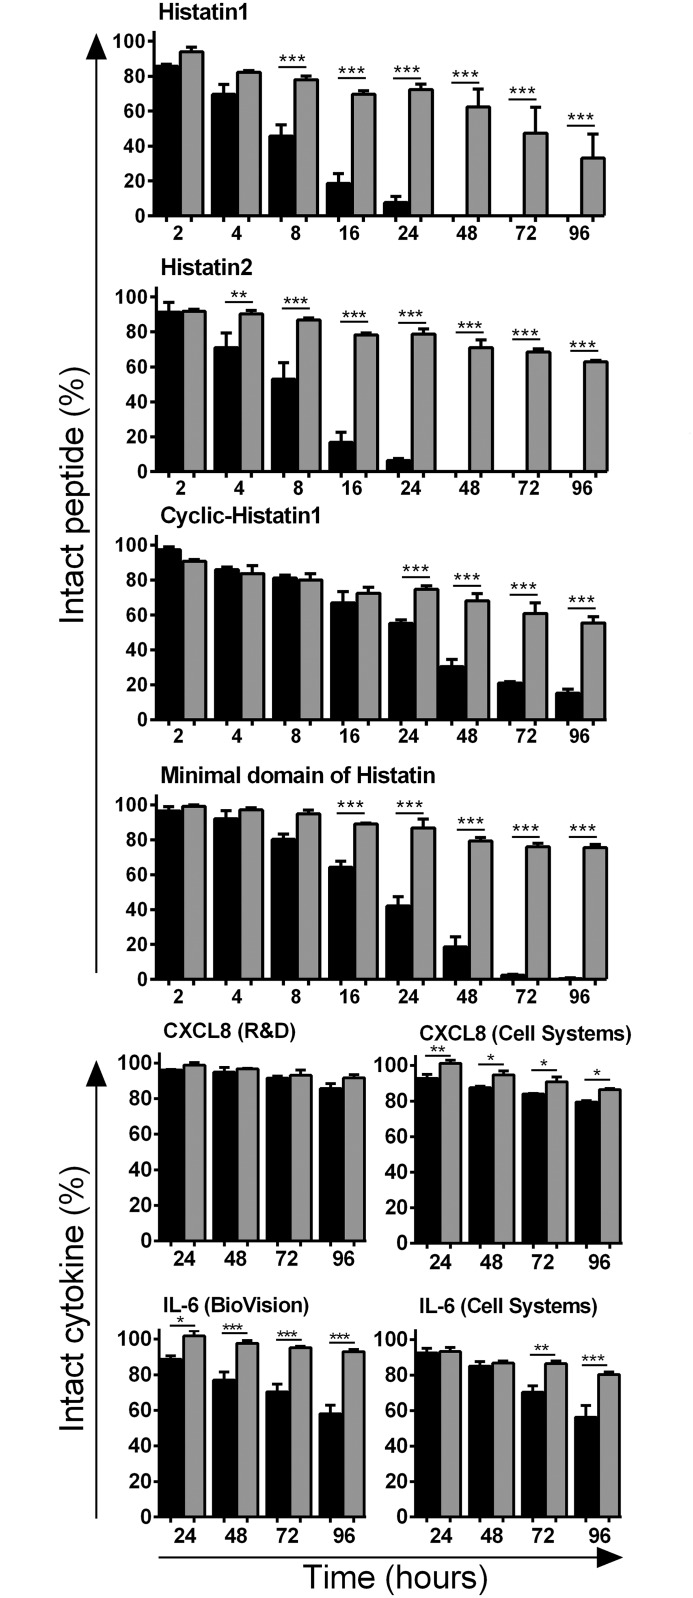
Protease inhibitors prevent breakdown of histatins and cytokines during incubation with chronic wound extract.Degradation of histatins and cytokines during incubation with CWE, with or without addition of protease inhibitors, as percentage of the start amount. Bars represent means ± SEM of three independent experiments, performed with CWE pools of 5 donors. Black bars = incubation with CWE, grey bars = incubation with CWE + PIC. * P <0.05, ** P <0.01, *** P <0.005.